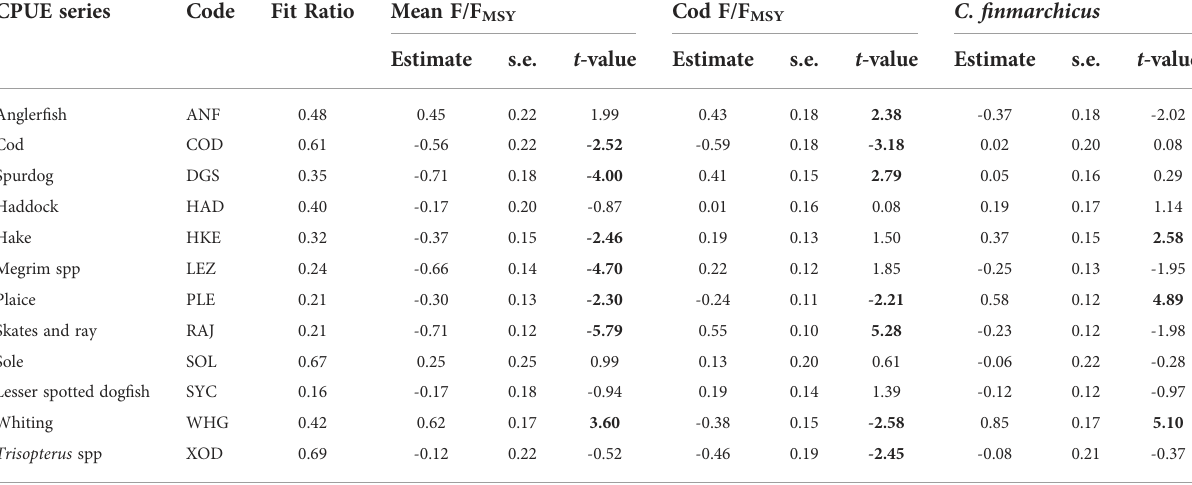
TABLE 3 FAO Code, fi t ratio, estimated regression coef fi cients, standard errors (s.e.) and t -values for each CPUE series in the optimal DFA